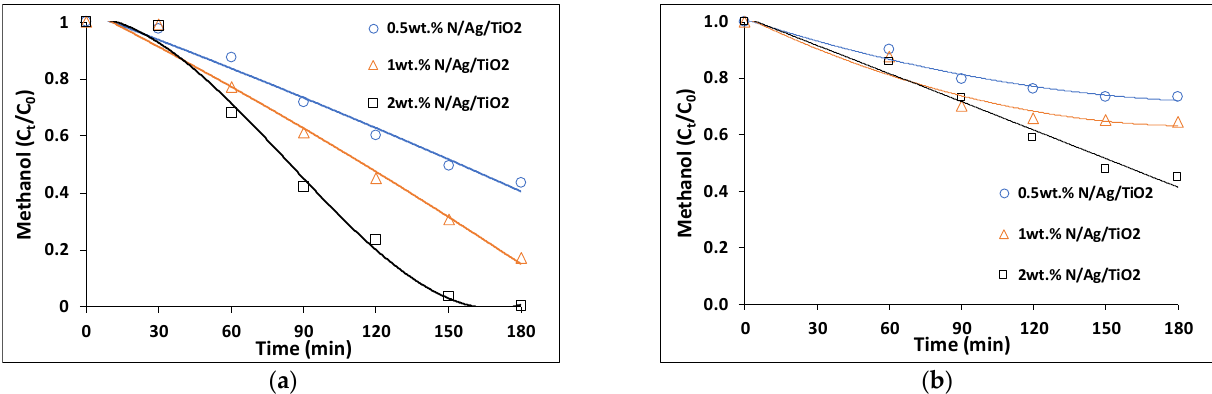
Figure 8. Methanol degradation with different loadings of N/Ag/TiO 2 coated on a mesh: 0.5 wt.%, 1 wt.% and 2 wt.% Runs were carried out under ( a ) near-UV light and ( b ) visible light irradiation. Note: Reported data are for at least three repeats with 15 ± 5% standard deviation (SD). Note: The close to 100% recorded carbon contained balance shows the consistent accounting of all carbon containing species during the experiments. Table 5. Methanol photodegradation rate under near-UV and visible light using a bare-TiO 2 and N/Ag/TiO 2 photocatalysts. The kinetic models used are of the pseudo first-order reaction type with kinetic constants being reported.